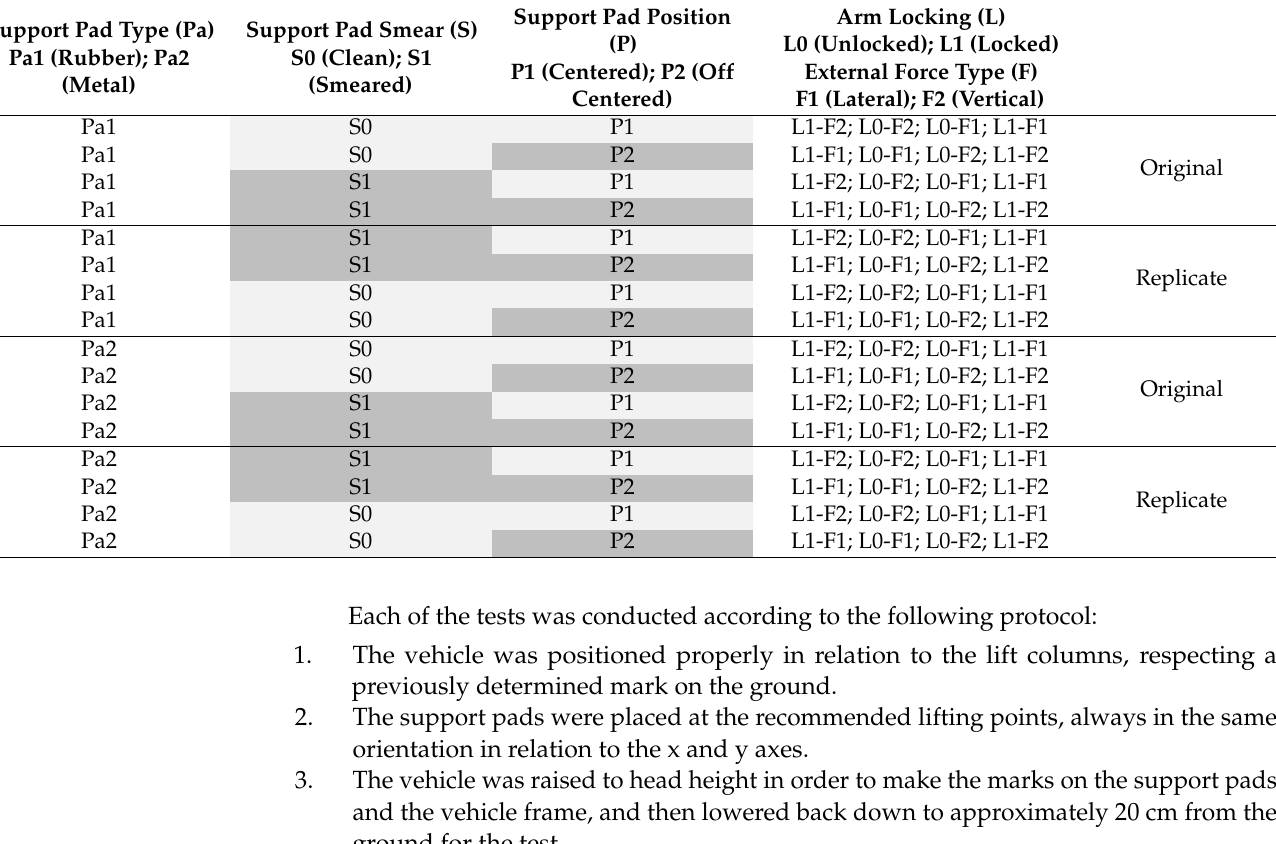
Table 3. Planning of tests for Pa1 and